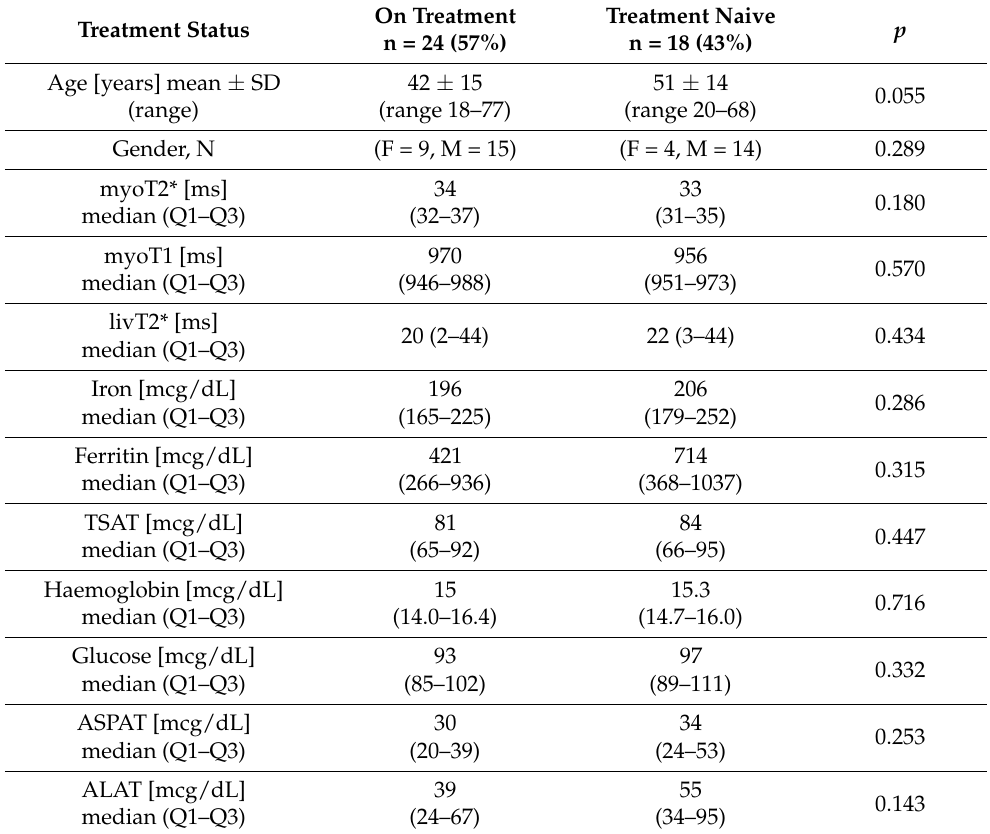
Table 5. Iron loading parameters on CMR and laboratory tests (iron turnover, glycemia, and liver